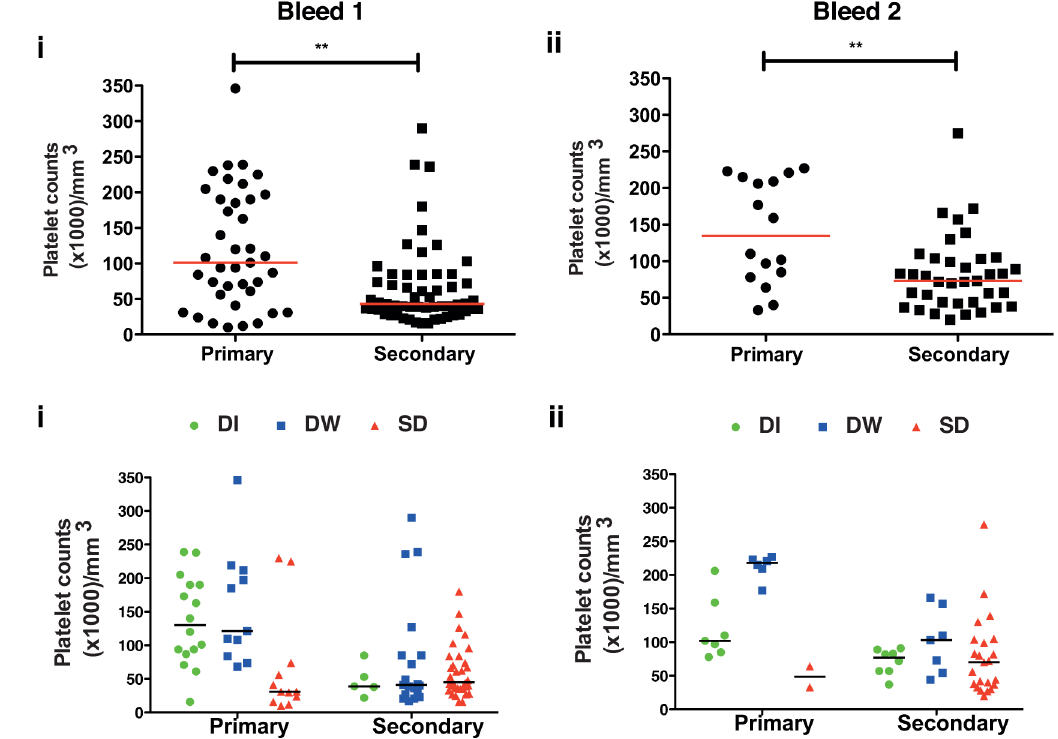
Fig 3. Relationship between platelet count and primary/secondary infections. (A) Platelet counts were measured at the time of admission, bleed 1 (i) or 48 h later, bleed 2 (ii) in patients with primary or secondary infections. (B) Platelet counts in bleed 1 (i) and bleed 2 (ii) of patients with primary or secondary infections categorized as per indicated disease severity. Median value is indicated. Statistical significance was determined by Mann-Whitney test. ** P <